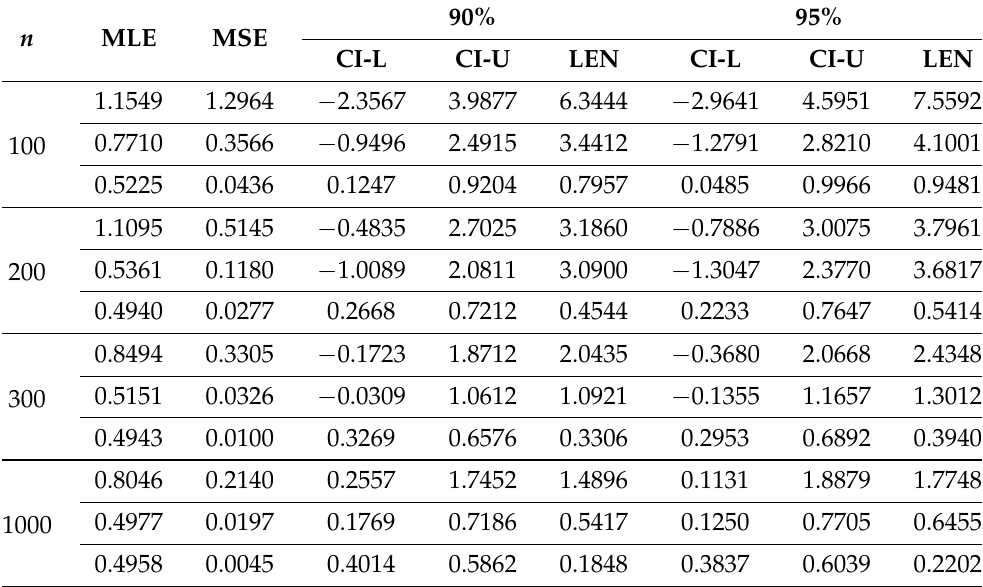
Table 3. Numerical values of the MLEs, MSEs, CI-Ls, CI-Us, and LENs for the parameters of the UG/G model for Config2.